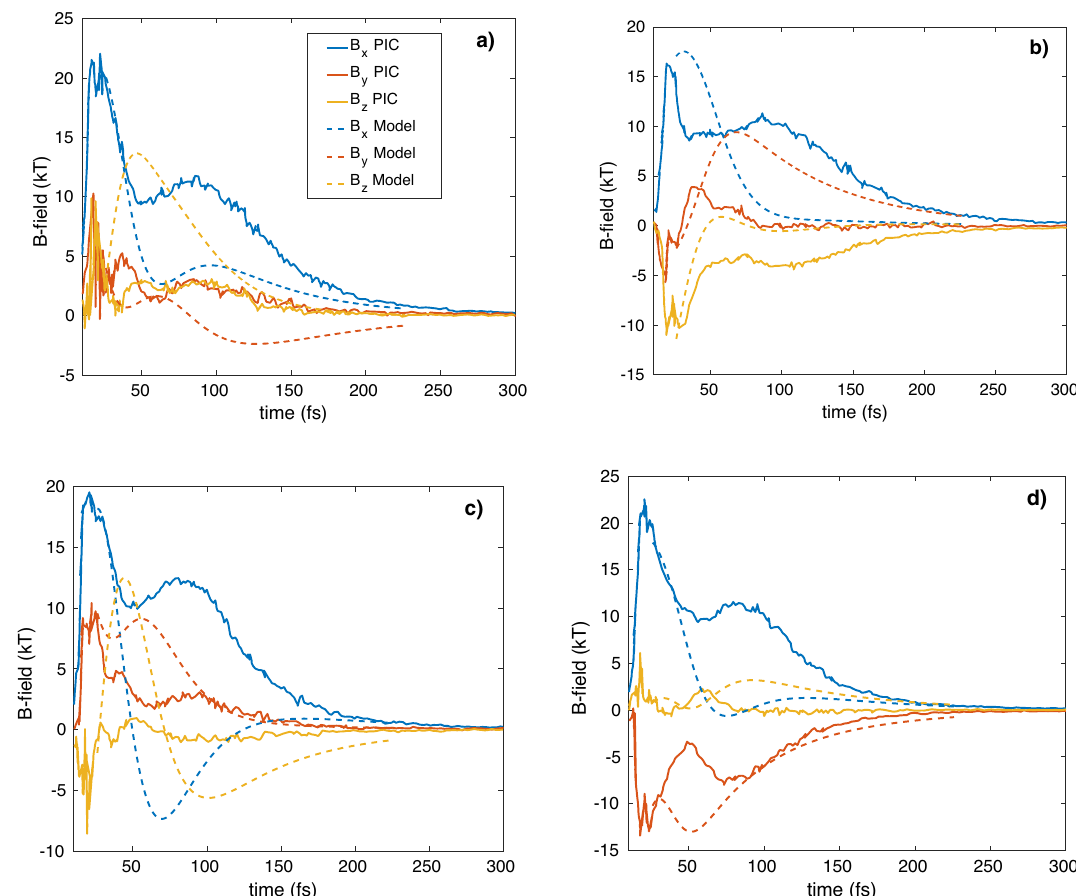
Figure 5. The time dependence of the magnetic field components for Au +30 4-x clusters irradiated by a laser pulse of I L = 5.6 × 10 20 W/cm 2 intensity and 6 fs duration, obtained by PIC simulations (modulated lines) and analytically (smooth lines of the same